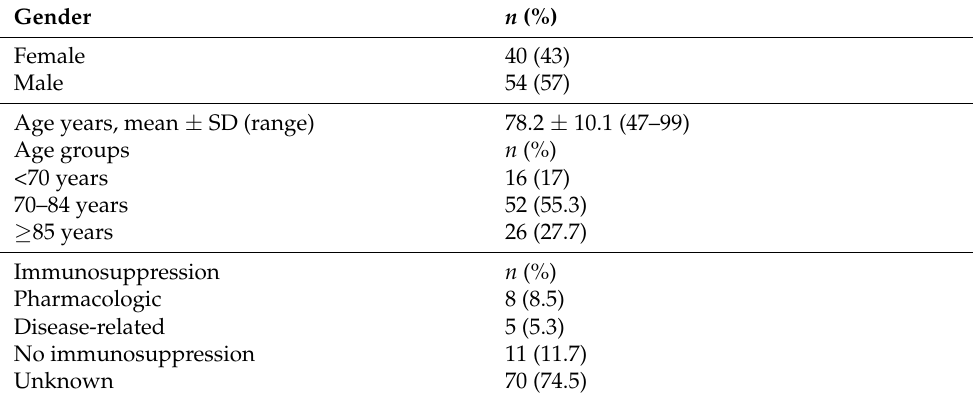
Table 1. Patients’ characteristics at presentation (N = 94).